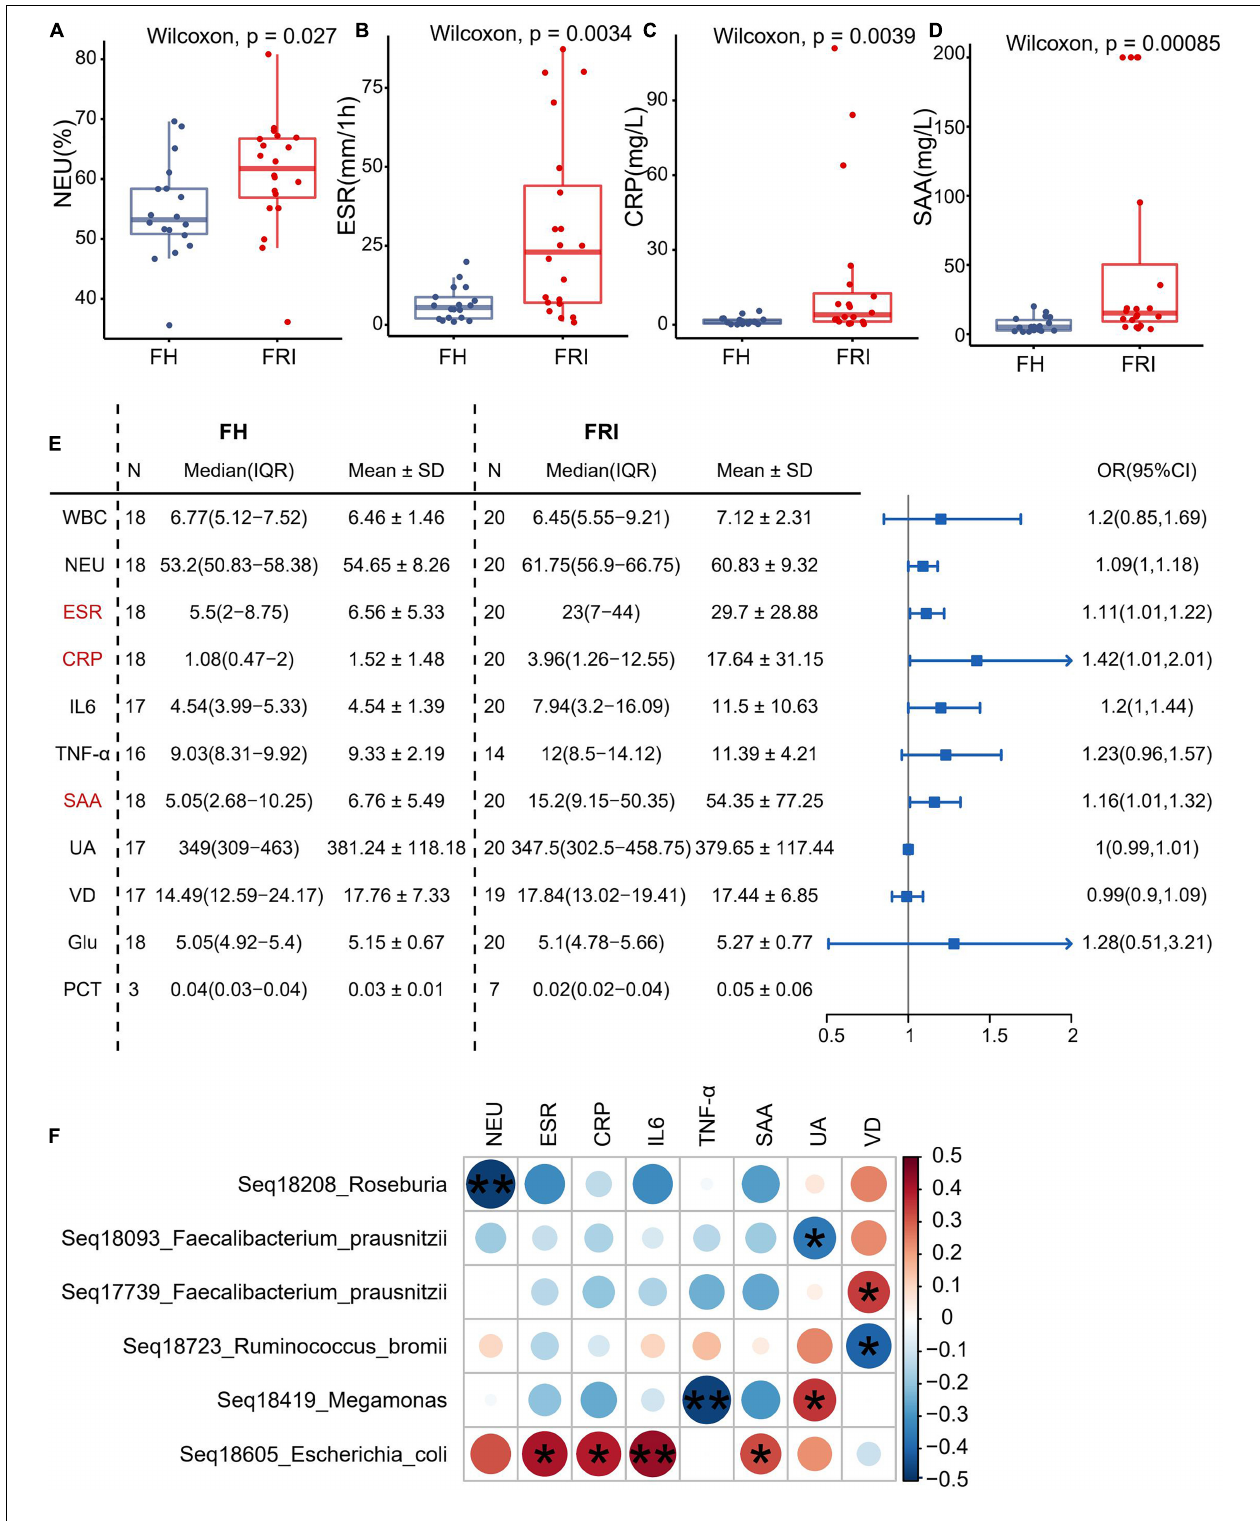
FIGURE 4 | Fecal microbiota composition in relation to serum inflammatory markers. (A–D) Levels of serum inflammatory markers in FRI and FH groups. (E) Odds ratio (OR) values of serum inflammatory markers in FRI group compared to FH group. (F) Bubble chart showing significantly correlations between bacterial amplicon sequence variants (ASVs) and serum inflammatory markers. NEU, percentage of neutrophils; ESR, erythrocyte sedimentation rate; CRP, C-reactive protein; SAA, serum amyloid A; WBC, white blood cell count; IL-6, interleukin-6; TNF- α , tumor necrosis factor- α ; UA, uric acid; VD, vitamin D; Glu, glucose; PCT: procalcitonin. * P < 0.05, and ** P <